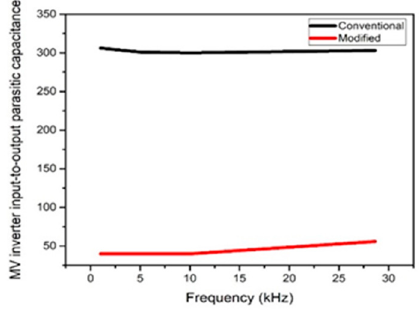
Figure 14. Toroidal transformers at 360° sectored winding, parasitic coupling capacitance comparison between the conventional and modified design of high-frequency link based MV inverter systems.